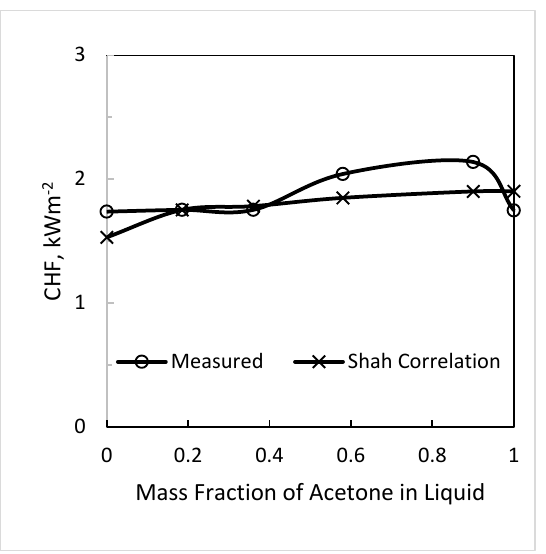
Figure 4. Comparison of the data from Carne (1963) [11] for acetone–toluene mixture in an annulus with the Shah (2015a) [27] correlation. Liquid velocity is 2.18 ms − 1 , inlet subcooling is 60 K, and pressure = 2.23 bar.